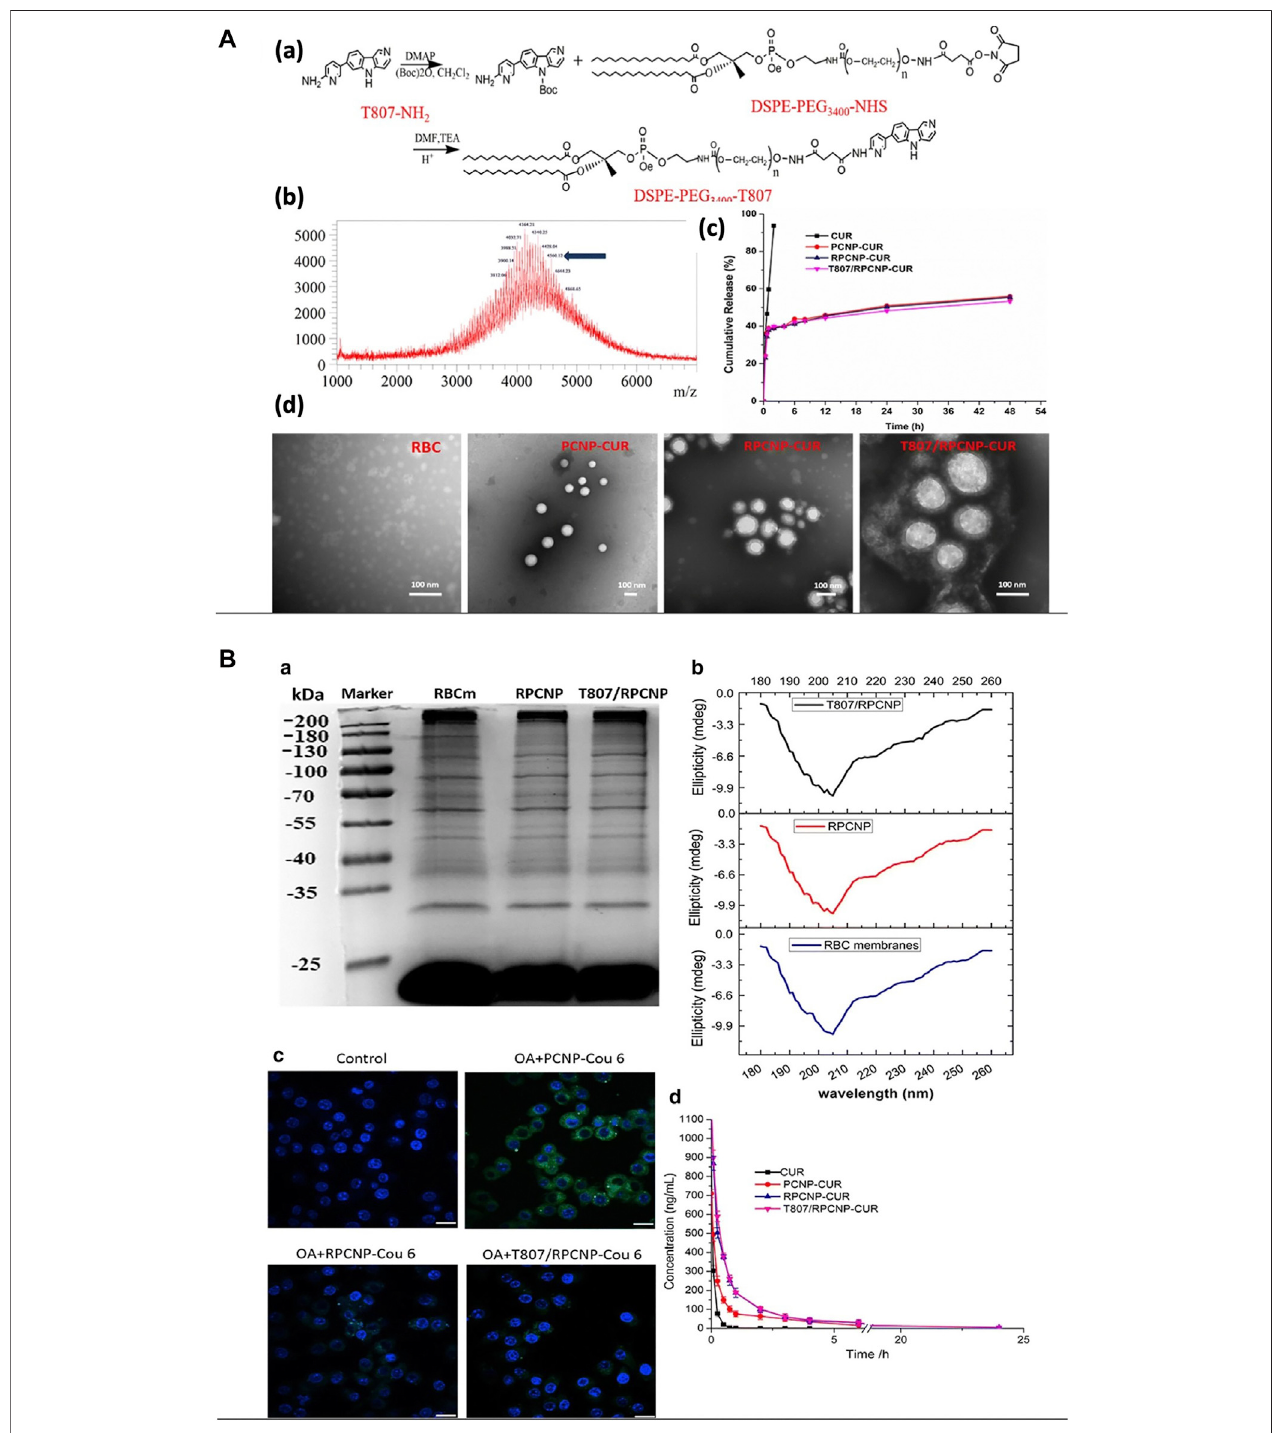
FIGURE 10 | Using RBC membrane as a camou fl age for therapeutics. (A) Preparation and characterization of nanoparticles. (B) The stealth properties of RBC membrane-coated NPs in vitro and in vivo . Adapted from Gao et al. (2020a).